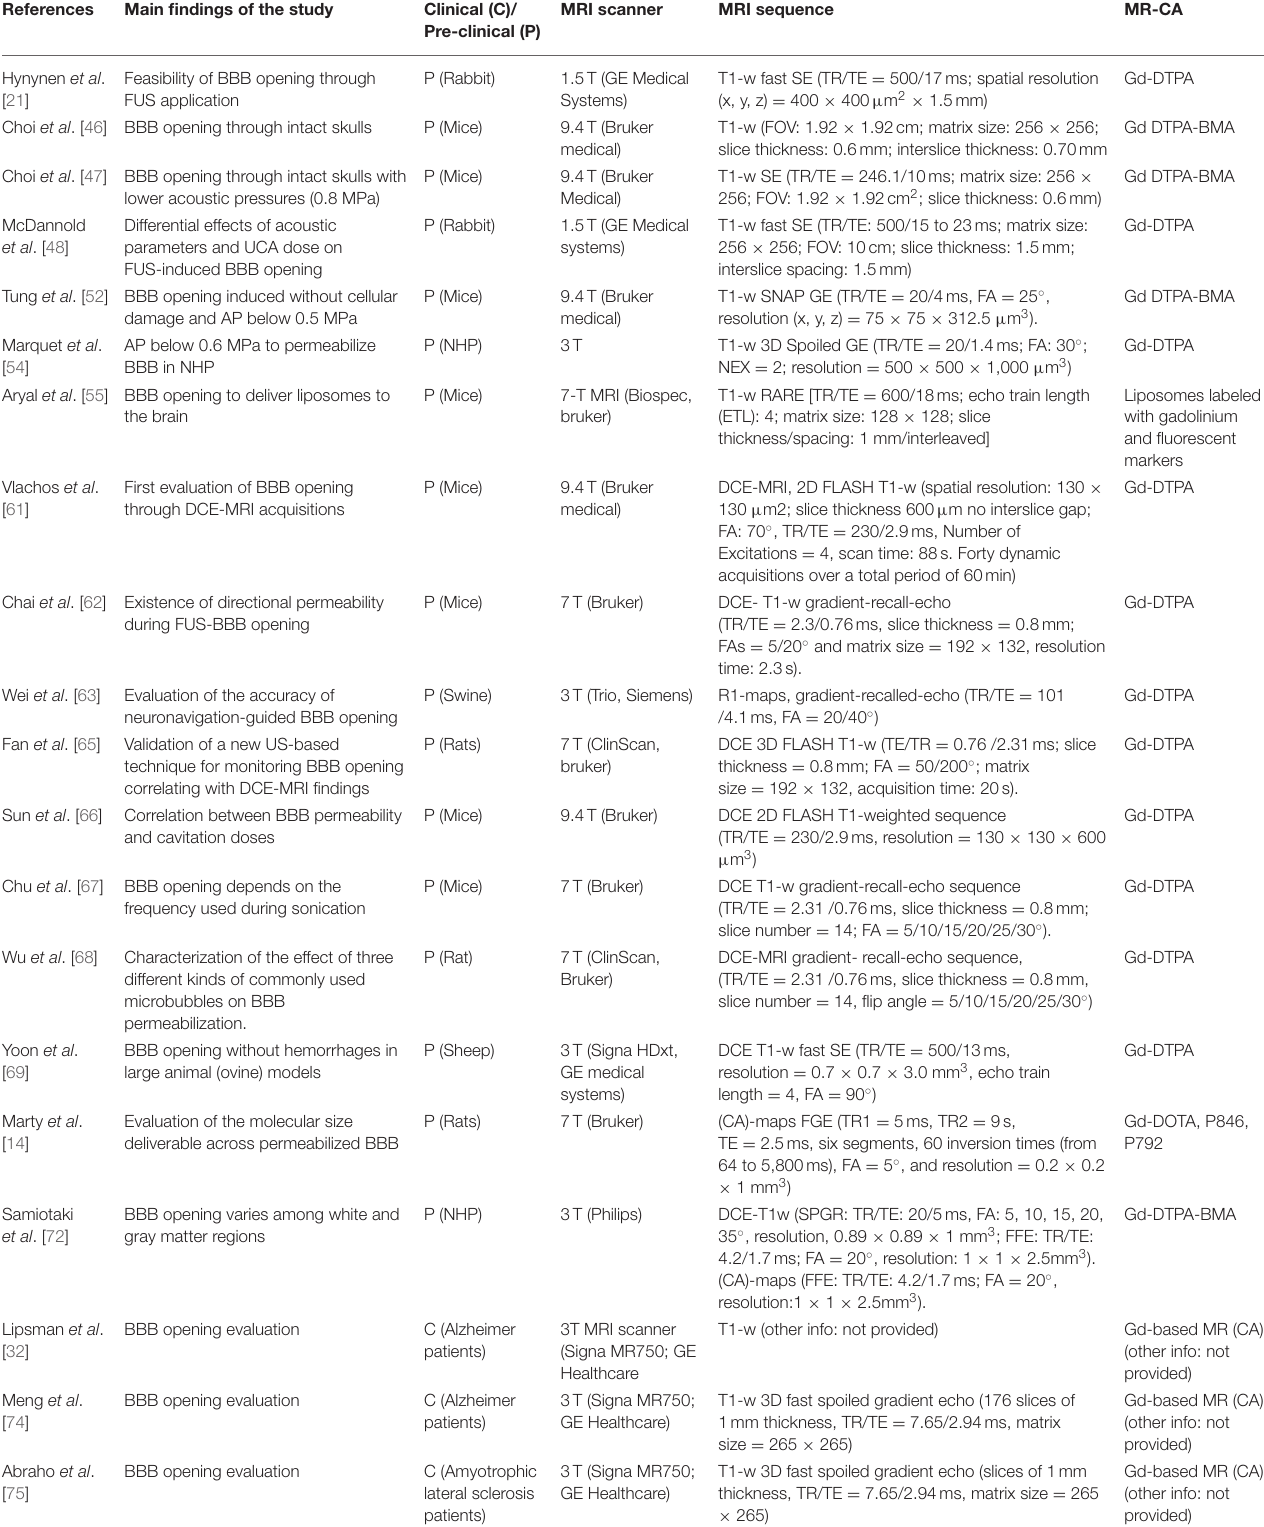
TABLE 1 | Specifications of studies, included in this narrative review, using MR-CA administration to evaluate the opening of the BBB induced by FUS